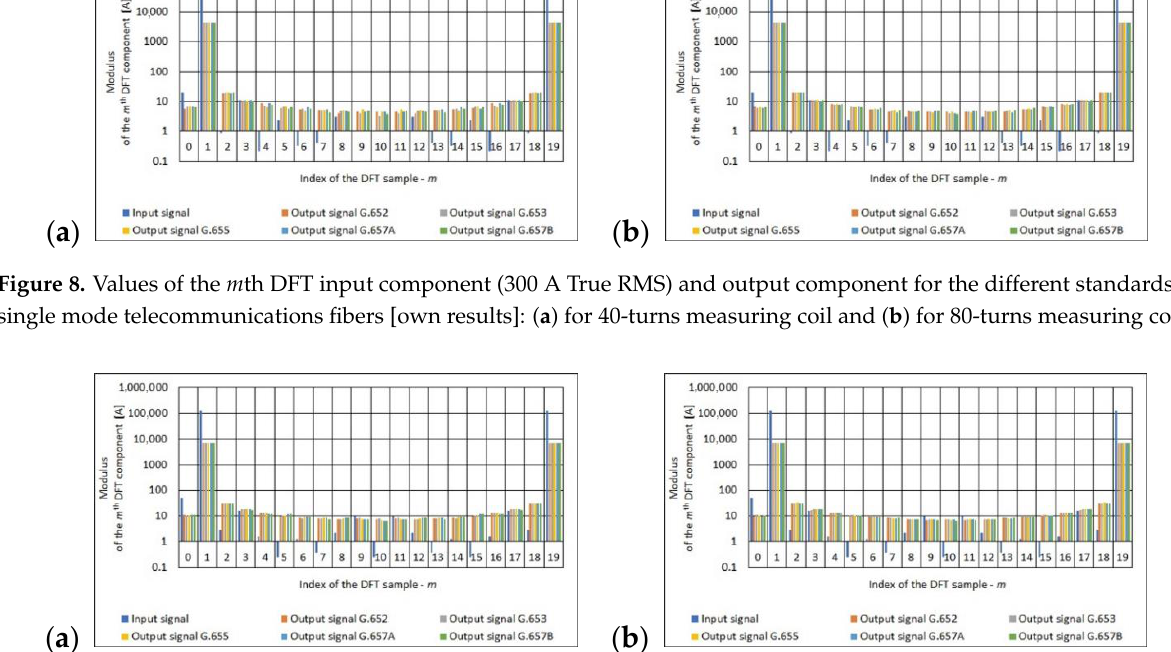
Figure 9. Values of the m th DFT input component (500 A True RMS) and output component for the different standards of single mode telecommunications fibers [own results]: ( a ) for 40-turns measuring coil and ( b ) for 80-turns measuring coil.